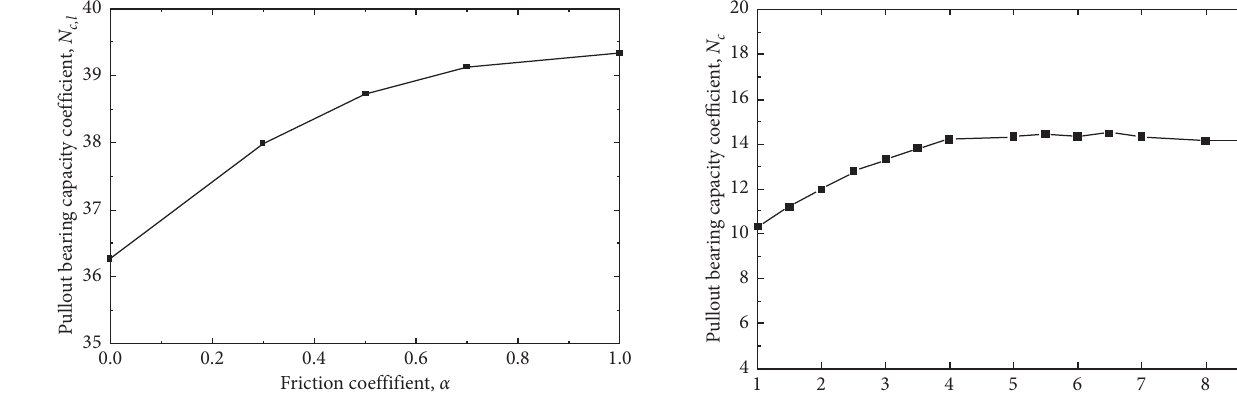
Figure 11: Variation in N c , l with the friction coefficient between the plate anchor and soil α ( H 1 � 6m, H 2 �